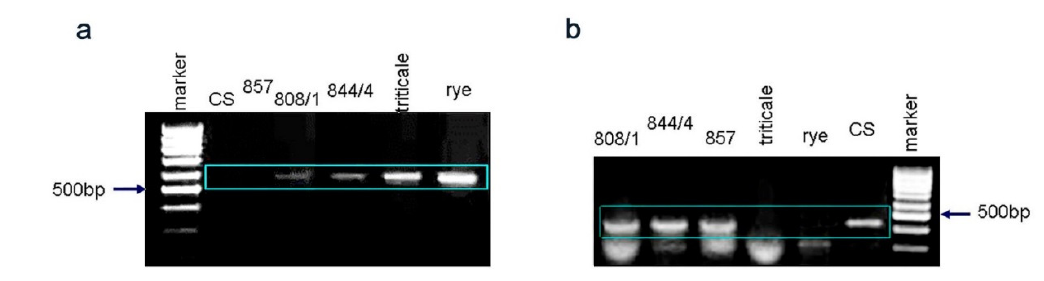
Figure 2. PCR analysis of the hybrid lines parental triticale, rye and common wheat Chinese Spring with the markers F3h-R1 ( a ) and Ppd-D1 ( b ).